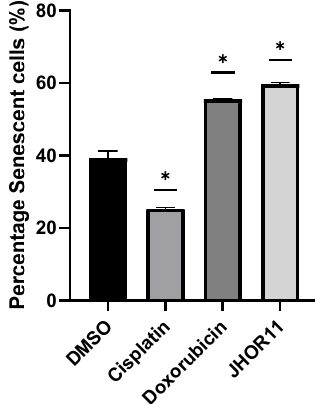
Figure 10. Quantification of senescent A2780 cells after 48 h incubation with IC 50 of complex JHOR11, 0.1% ( v / v ) DMSO as vehicle control, 3.5 µ M cisplatin and 0.1 µ M doxorubicin as positive control. Bars represent the average ± SD. * p value < 0.05 relative to control.